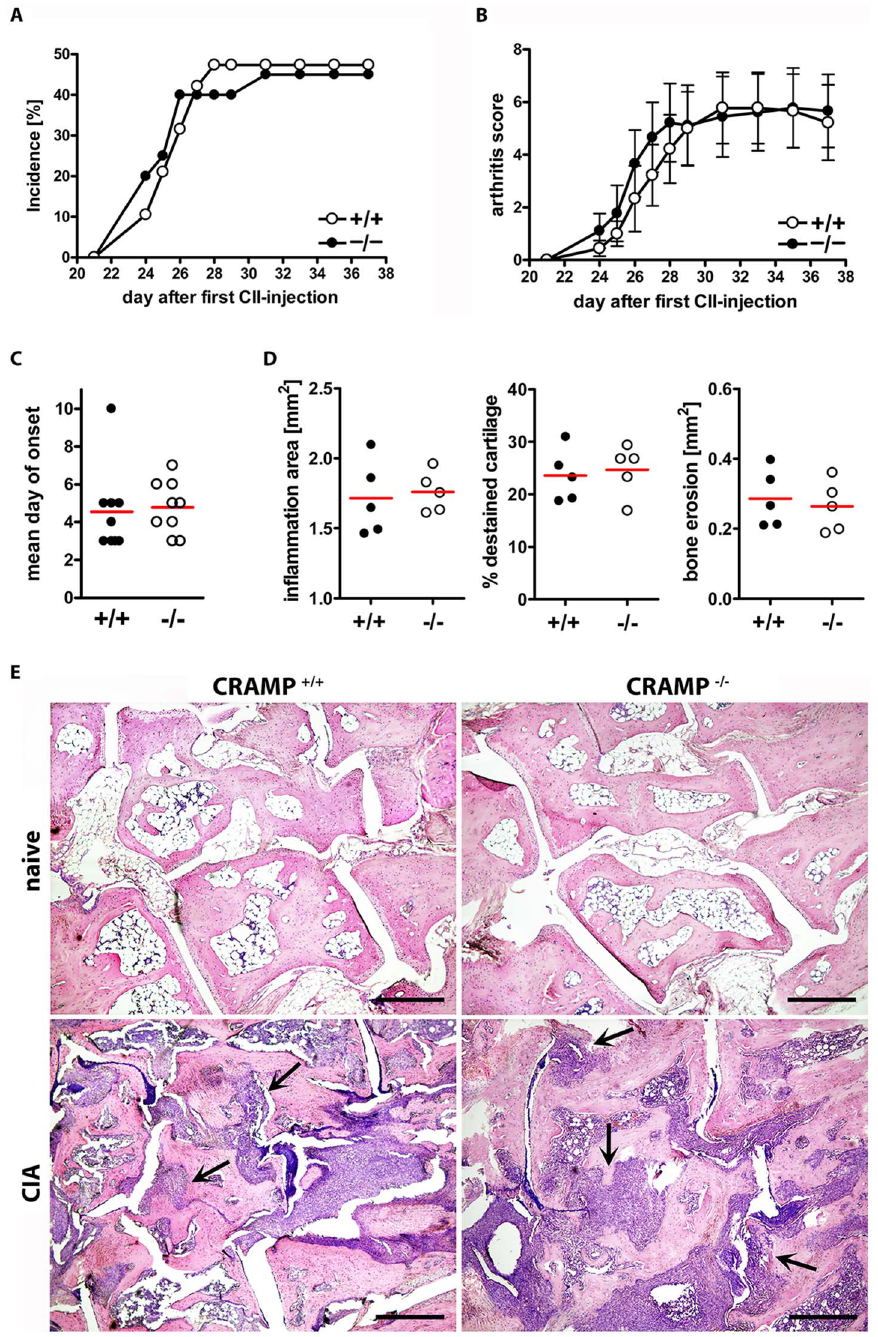
Fig. 8. Comparison of collagen-induced arthritis (CIA) in WT and CRAMP-deficient mice. Incidence (A) of CIA and severity in affected mice (B). No significant differences could be found by comparing area under the curves of arthritic WT mice (n 5 9) and CRAMP-deficient mice (n 5 9) by Student’s t-test. Curves show means ¡ S.E.M. (C) Onset of CIA is not significantly different in CRAMP + / + and CRAMP 2 / 2 mice. (D) Histomorphometric analysis of hind paws from WT and CRAMP 2 / 2 mice for synovial inflammation, cartilage damage, and bone erosion. Shown are scatter plots of individual measurements and means. One dot represents one mouse. No significant differences could be found by Student’s t-test. (E) Representative H&E stainings of joint sections from naı¨ve mice and mice 37 days after collagen-injection. Left panels